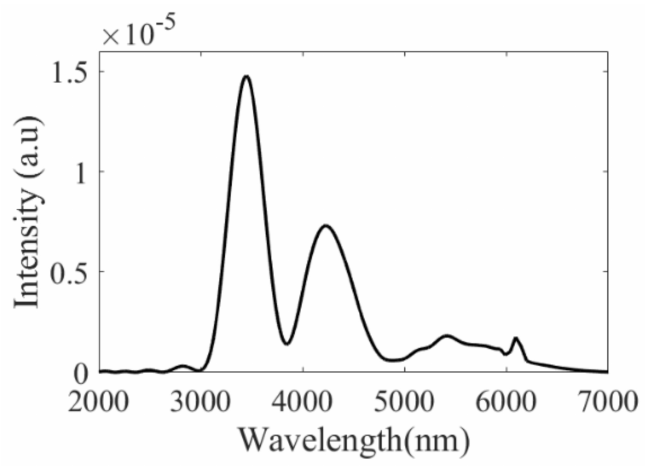
Figure 5. MIR spectrum at the HC-PCF